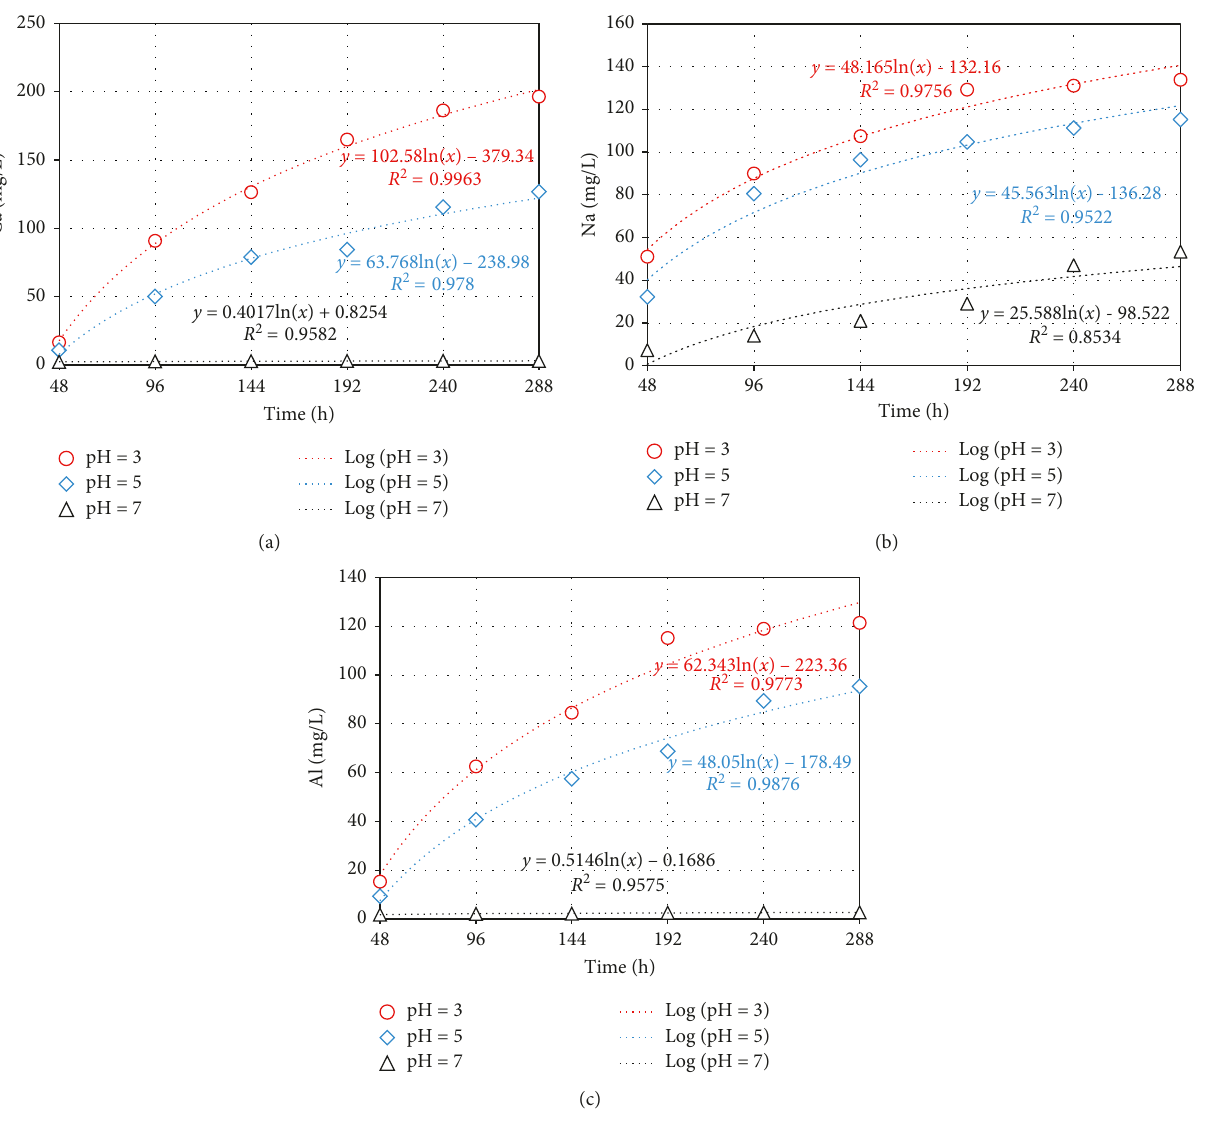
Figure 10: Ion release characteristics of gangues with 5–10 mm particle sizes immersed in solutions with different pH values.